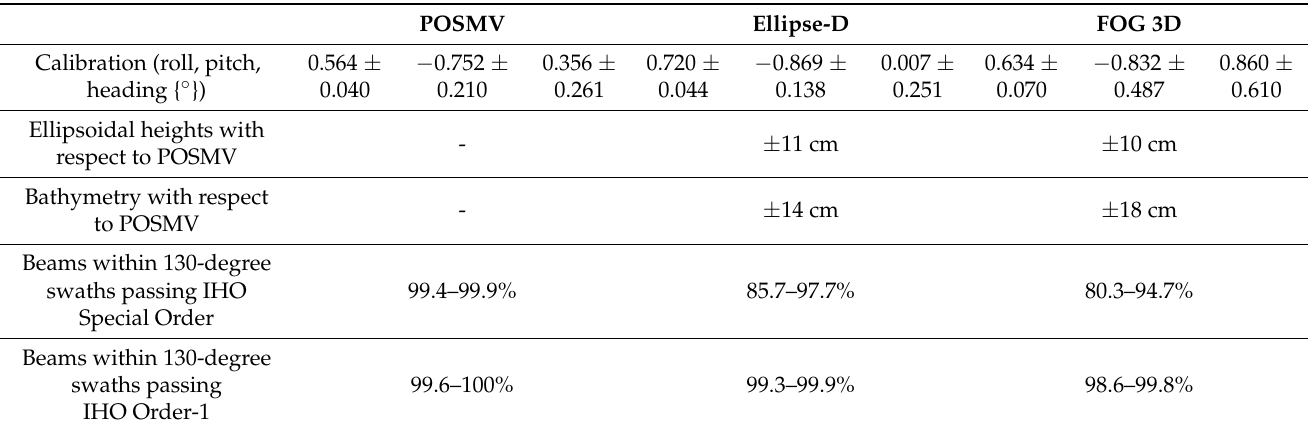
Table 6. Results and analysis summary.